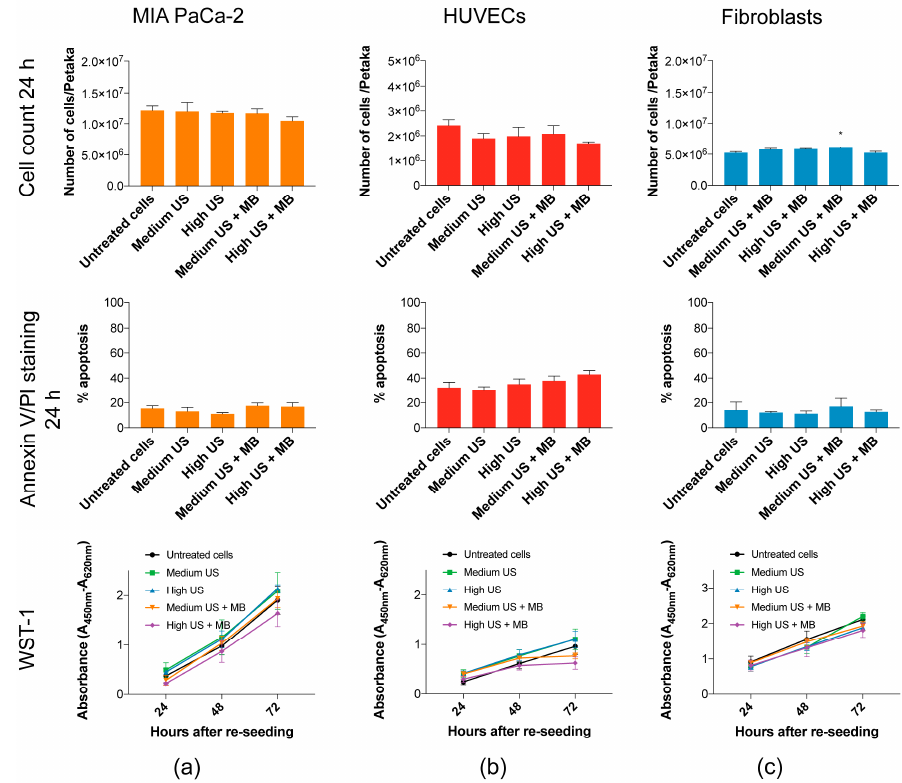
4 Figure 4. Viability of cells harvested after 24 h of incubation in Petaka. ( a ) No significant reduction in the cellcountor increasein apoptoticAnnexinV / PI-stainedcellsof MIA PaCa-2wasobserved. Themetabolic activity (WST-1) after re-seeding was not a ff ected by US + MB. ( b ) Cell count 24 h post-sonoporation of HUVECs is slightly, but not significantly, decreased in treated samples. Percentage of apoptotic cells 24 h post-sonoporation by AnnexinV / PI staining was increased, and also not statistically significant. No significant change was observed in the metabolic activity (WST-1) of the cells after re-seeding of the cells, although some reduction in metabolic activity was observed in cells exposed to US + MBs. ( c ) No significant reduction in the cell count, increase in apoptotic AnnexinV / PI stained cells or reduced metabolic activity (WST-1) after re-seeding of fibroblasts was observed. Mean ± SEM. * p < 0.05 (treated vs. untreated